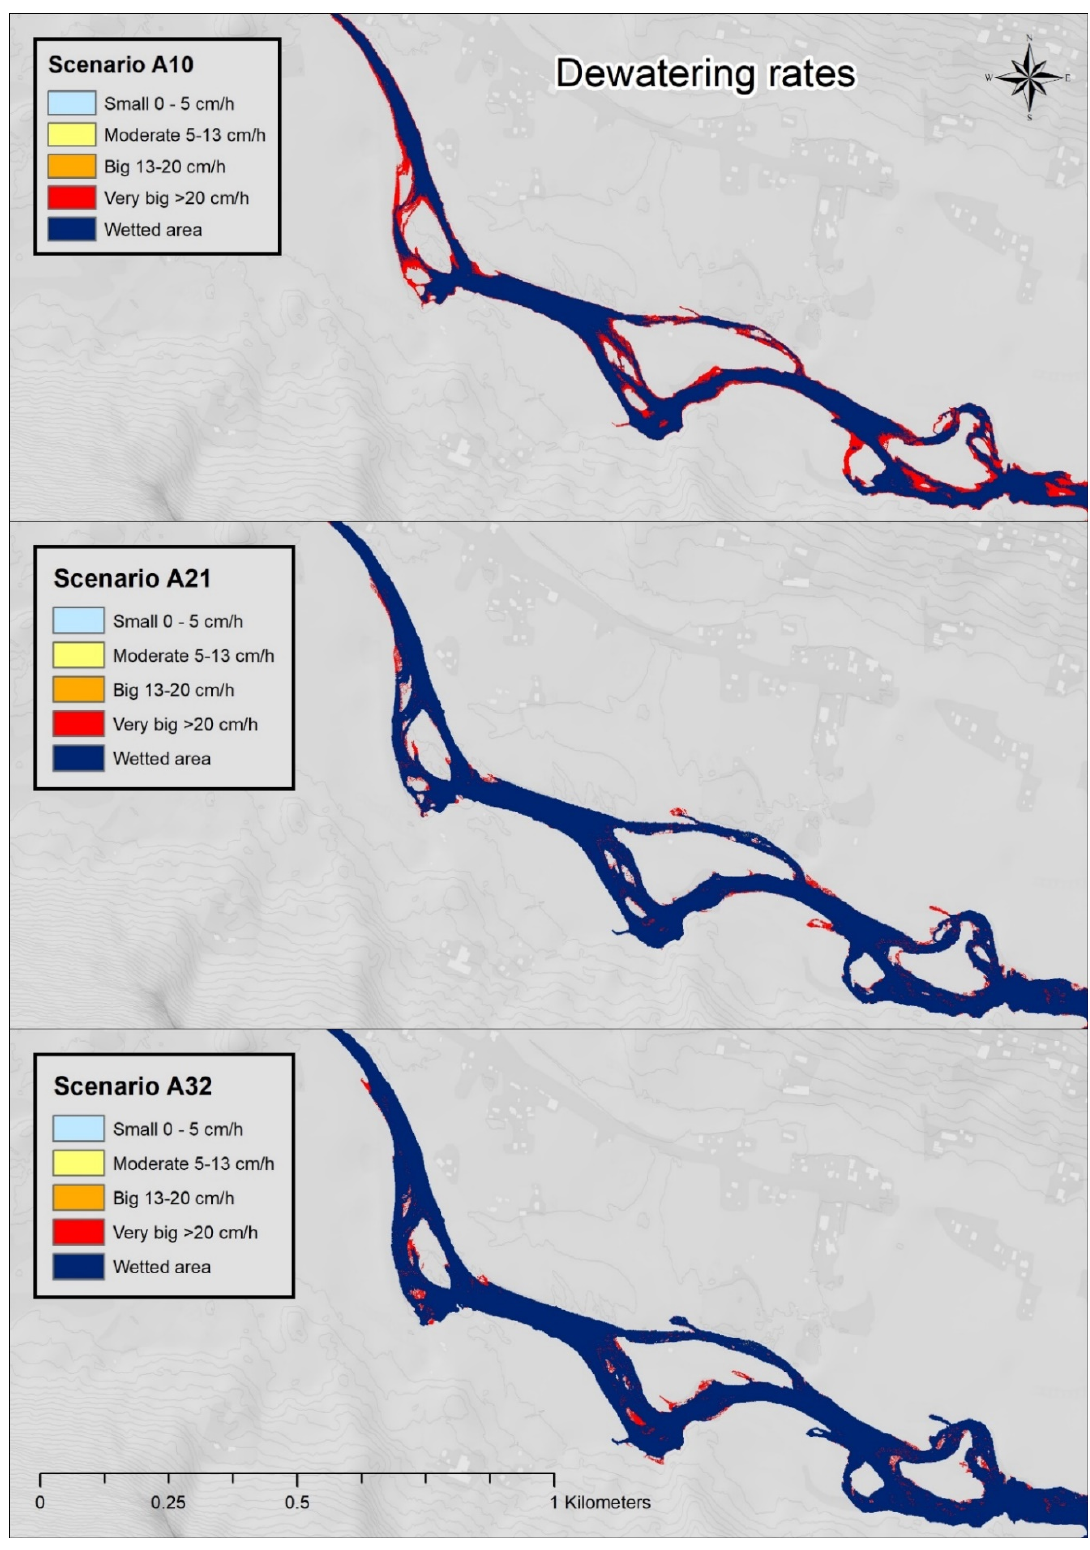
Figure A1. Dewatering rates scenarios A10, A21 and A32.